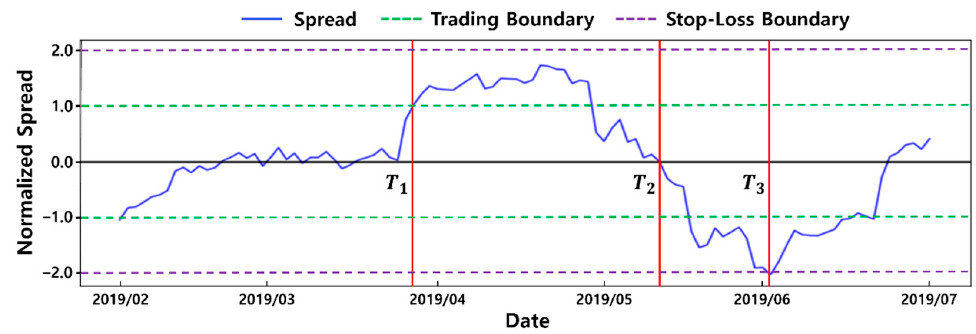
Figure 2. Normalized spread of the stock pair in Figure 1 (AOS and CCL).